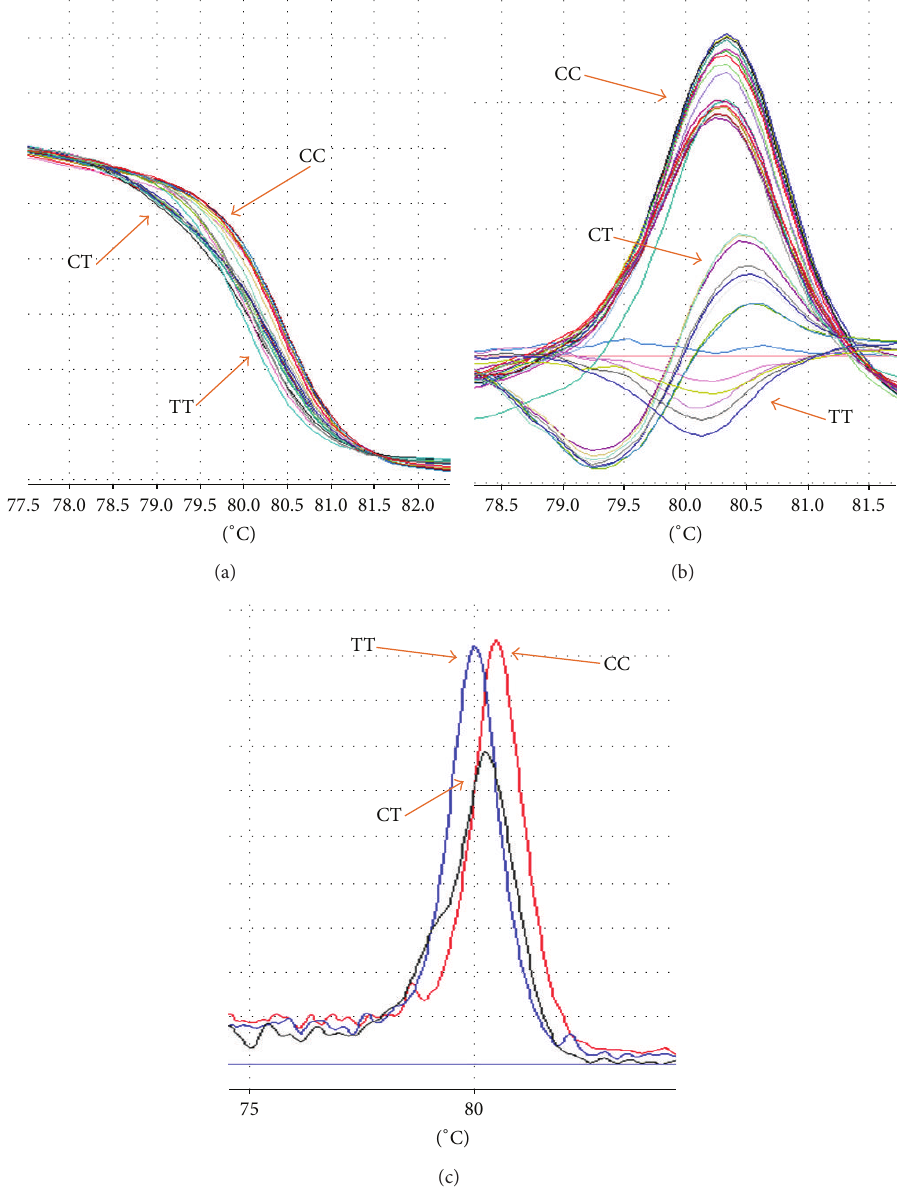
Figure 2: The difference graph of HRM analysis for the genotypes of C69T polymorphism. (a) demonstrated the normalized graph, (b) revealed the difference graph, and (c) was melting graph. In these graphs WT had higher Tm and HOM had lower